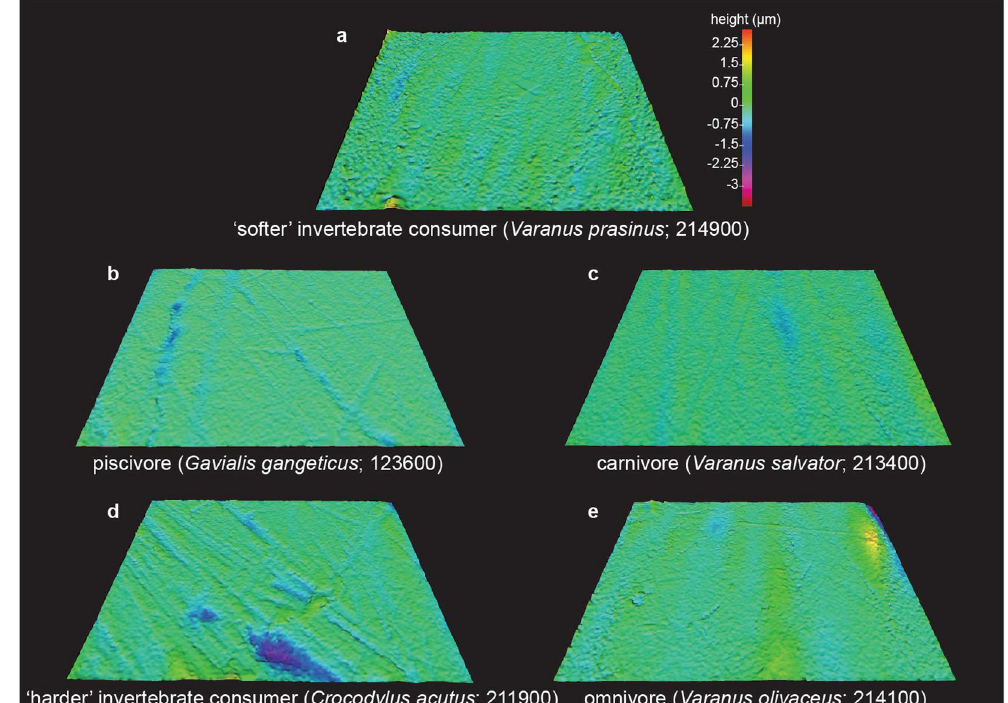
Figure 1. Examples of scale-limited reptile tooth surfaces for each dietary guild. ( a ) ‘Softer’ invertebrate consumer ( Varanus prasinus ). ( b ) Piscivore ( Gavialis gangeticus ). ( c) Carnivore ( Varanus salvator ). ( d) ‘Harder’ invertebrate consumer ( Crocodylus acutus ). ( e) Omnivore ( Varanus olivaceus ). Measured areas are 146 × 110 µ m in size. Topographic scale in micrometres. Numbers within brackets denote Leicester IFM sample